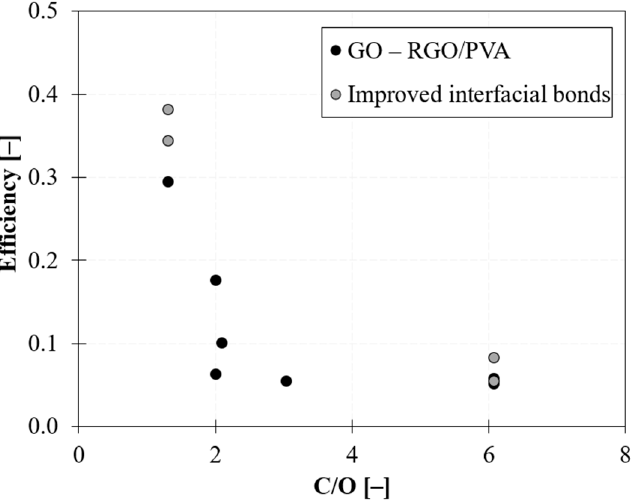
Figure 10. Influence of chemical interactions between filler and matrix: efficiency of reinforcement vs. C/O ratio in GO/PVA and RGO/PVA films.